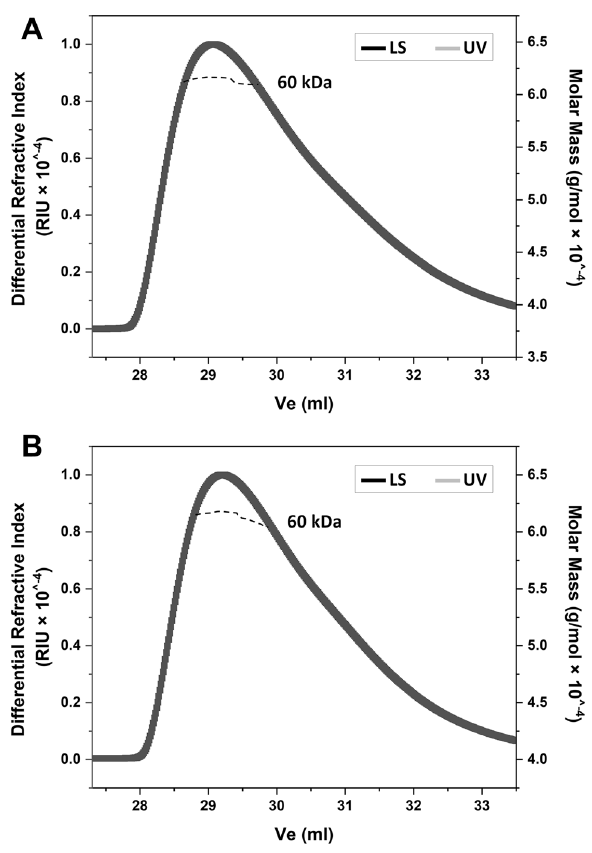
Figure 2. SEC–MALS of BaCcpC. Analysis of the oligomeric state of BaCcpC in the ( A ) presence or ( B ) absence of